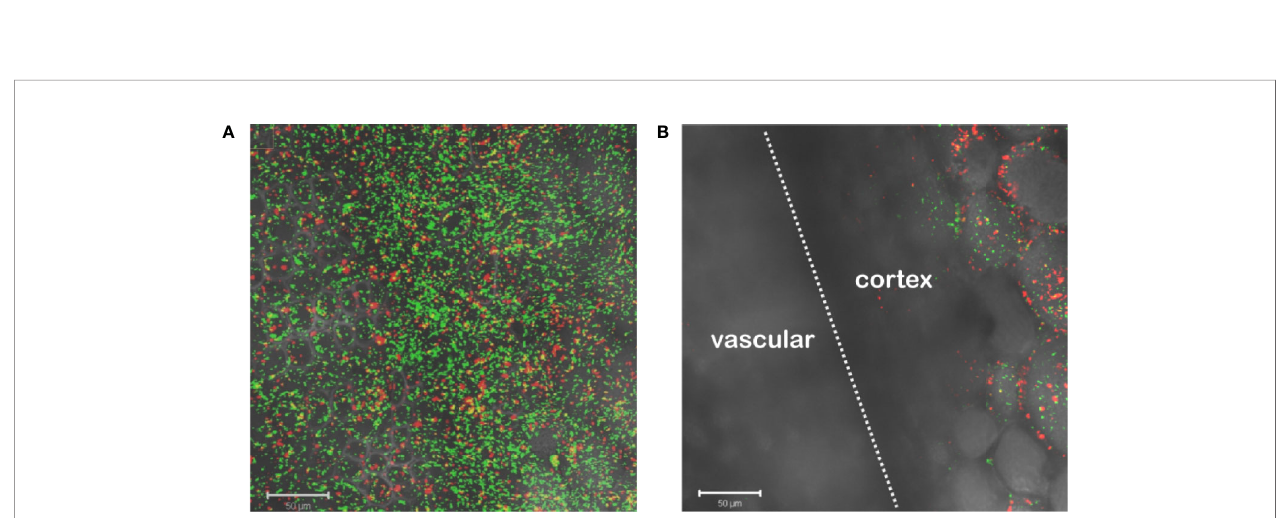
FIGURE 3 | Agrobacterium colonize into the apoplast of tobacco explants within two days of co-cultivation. YHL324 s+ colonize on the surfaces (A) and 50 µm below the surface (B) of the stem explants. The white dashed line indicates the junction between vascular tissue and the cortex tissue.